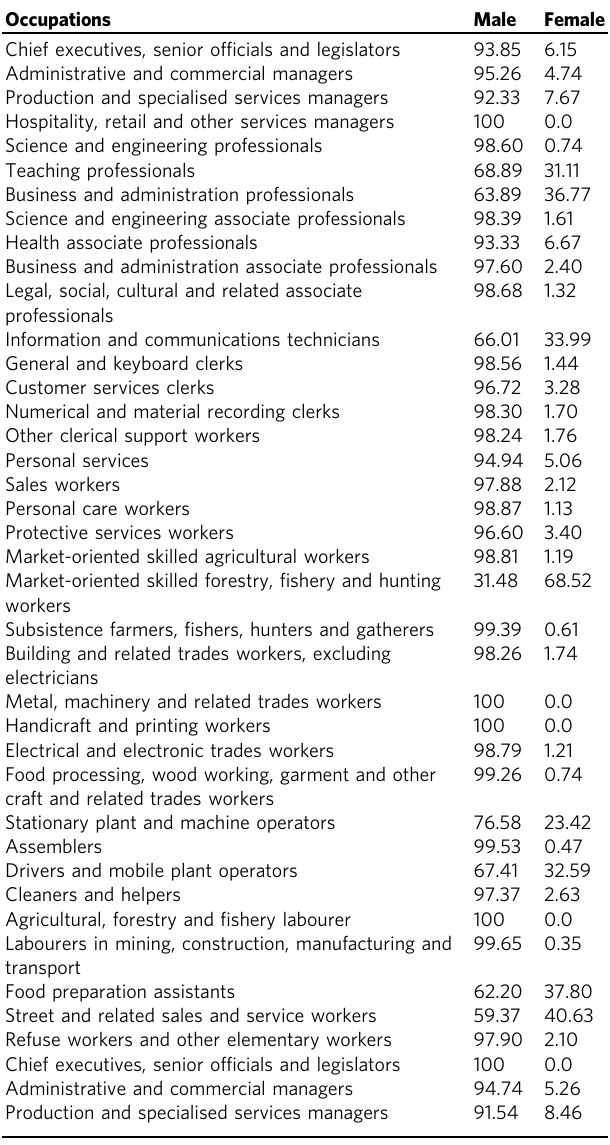
labour market. Gender and region . Figure 2 plots the segregation curve for males and females in the rural and urban regions. The cumulative proportion of total employment is presented on the horizontal axis, while the cumulative proportion of each gender group is presented on the vertical. The curve corresponding to male workers in rural and urban regions is above that of female workers. This implies that women occupy a more constrained position in the labour market. The comparison of males in rural and urban regions shows the high segregation of males in urban areas compared with rural areas. Table 5 provides various measures of local segregation. All the indexes indicate that females suffer higher segregation in both regions than males. A comparison of female workers in both regions shows higher segregation for women in rural areas, while the comparison of the male group shows that men in urban areas suffer relatively higher segregation than those in